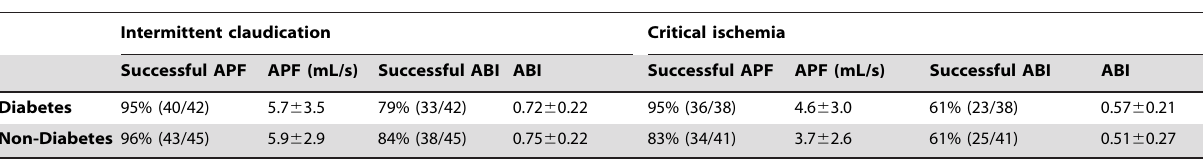
Table 3. APF and ABI values and success rates in subgroups of patients.